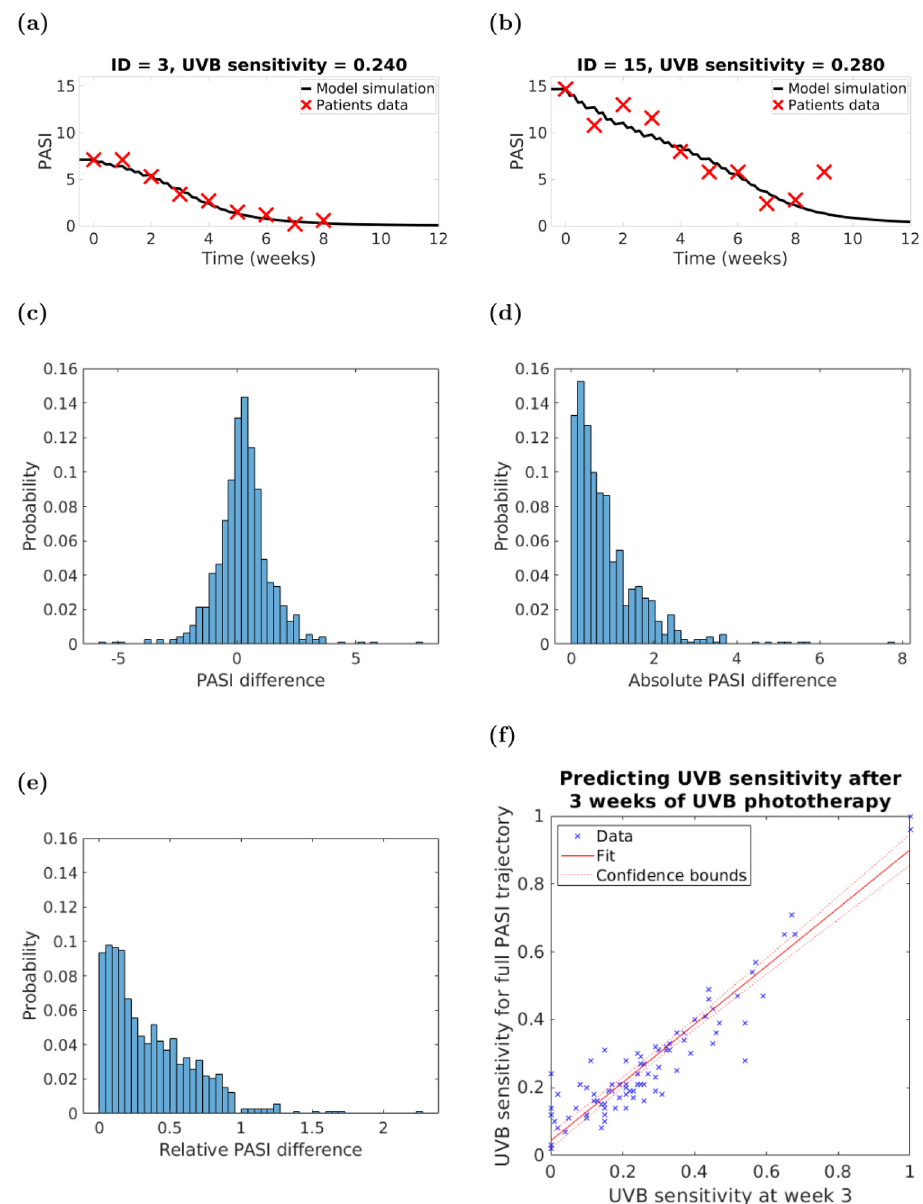
Fig 5. PASI measurements and UVB doses over the first three weeks of the therapy are sufficient to predict the UVB sensitivity uvb s parameter, which allows high-accuracy model personalisation. Panels: (a,b)—results of parameter fitting for two different patients; (c)—distribution (n = 754) of the difference between the model PASI simulation C � and the patients’ actual PASI data; (d)—distribution (n = 754) of the absolute value of the difference between the model simulation and patients’ PASI data; (e)—distribution (n = 738) of relative PASI difference calculated as a ratio between the absolute PASI difference and the corresponding PASI value (excluding those values for which corresponding PASI = 0; n = 16), (f)—results of fitting uvb end of the